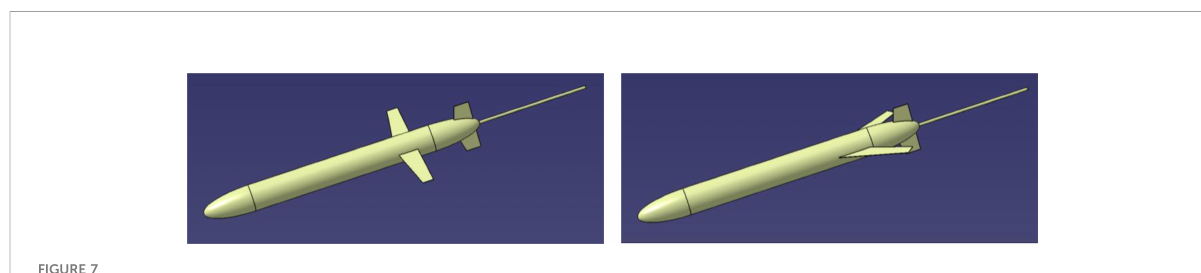
FIGURE 7 Parameterized model of hydrodynamic